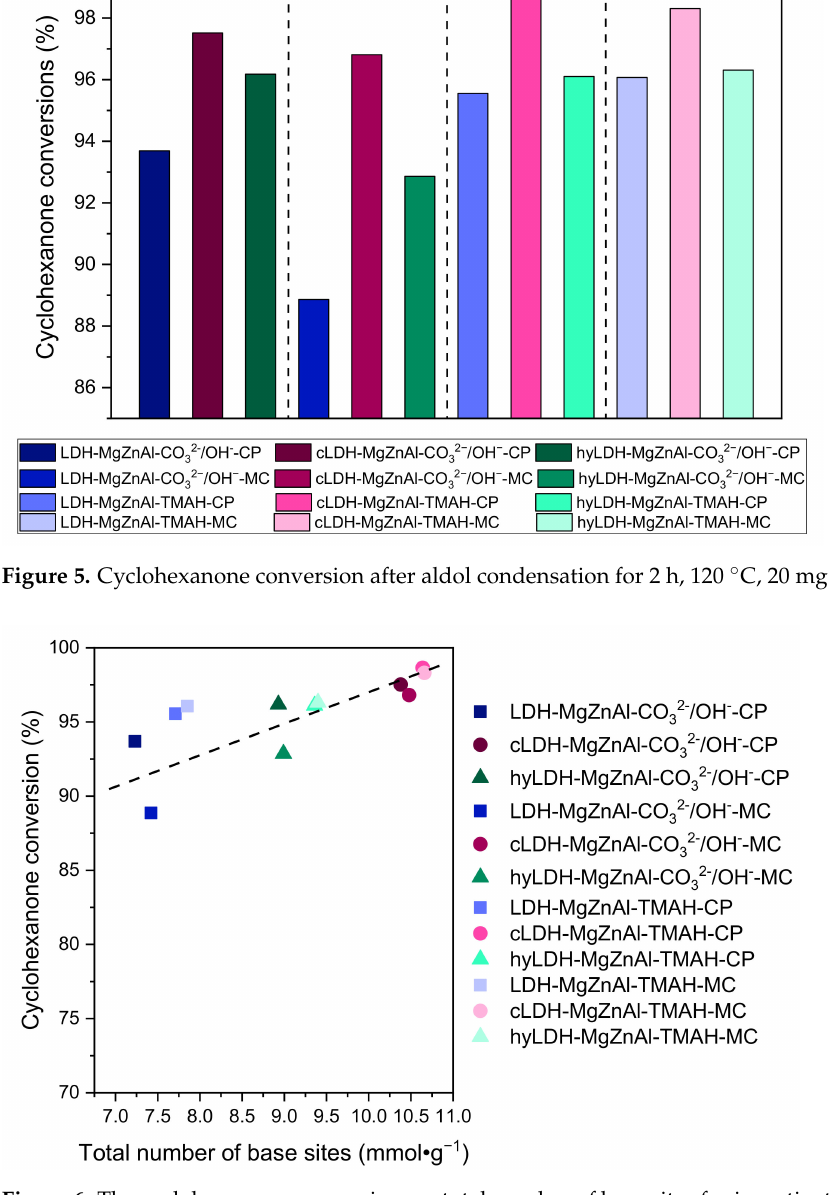
Figure 6. The cyclohexanone conversion vs. total number of base sites for investigated